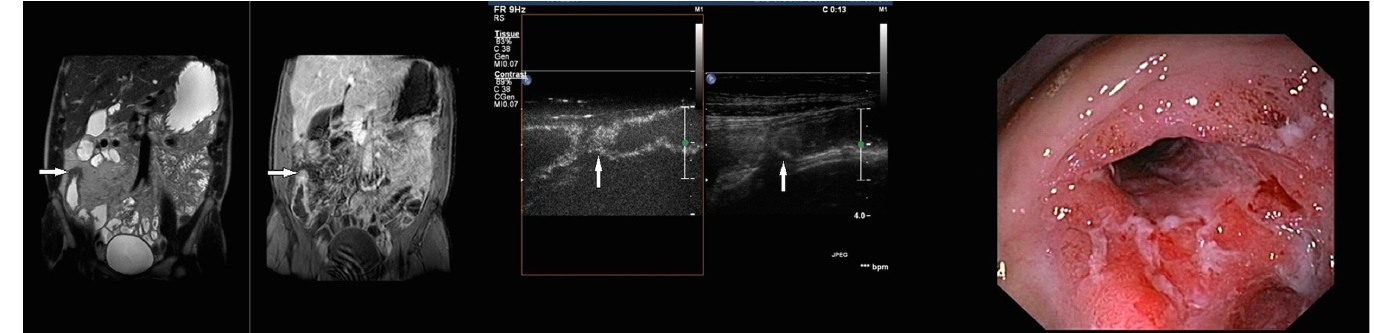
Fig 3. Thirty-one-year-old female patient with Crohn ’ s disease and stenosis of the ileocolic anastomosis after ileocecal resection. A: Coronal MR Enterography images (T2-weighted single-shot turbo spin-echo on the left image; T1-weighted fat saturated, spectrally attenuated inversion recovery after Gadoteric acid administration, on the right image) of a patient with stenosis (white arrow) and increased enhancement of the ileocolic anastomosis (white arrow). B: Longitudinal Contrast enhanced ultrasound (Gray scale ultrasound image, on the right side; Contrast enhanced ultrasound image, on the left side), of the same patient with a short stenosis of the ileocolic anastomosis (white arrow) and increased enhancement after Sonovue administration (white arrow). C: Endoscopic image of the same patient showing an ulcerative stenosis of the neoterminal ileum.